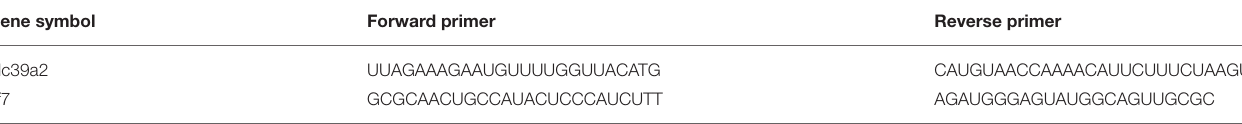
TABLE 1 | siRNAs designed for rat Slc39a2 and Irf7. Gene